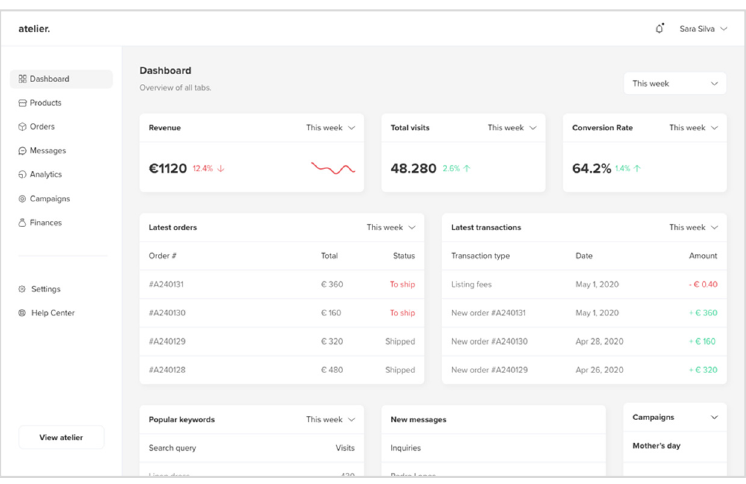
Figure 9. Sellers: Dashboard. Self-source, 2020.